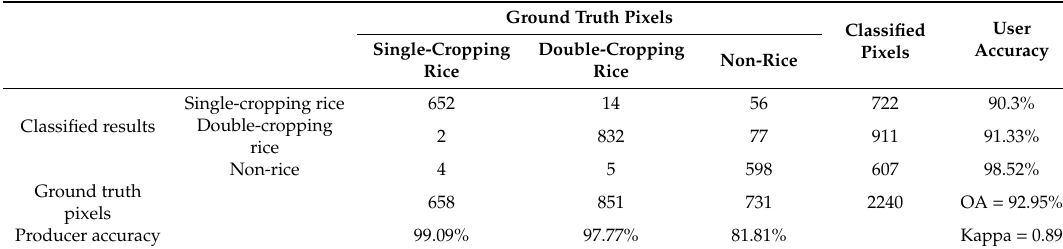
Table 2. Confusion matrix between ILMP-Rice in Nanchang County and validation points from high-resolution images via Google Earth and in-situ data.